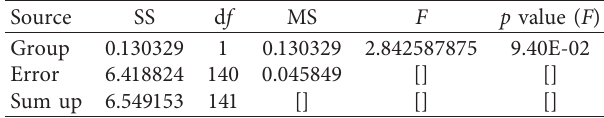
Table 26: ANOVA analysis of quantile based neural network and model integration algorithm and integrated model.